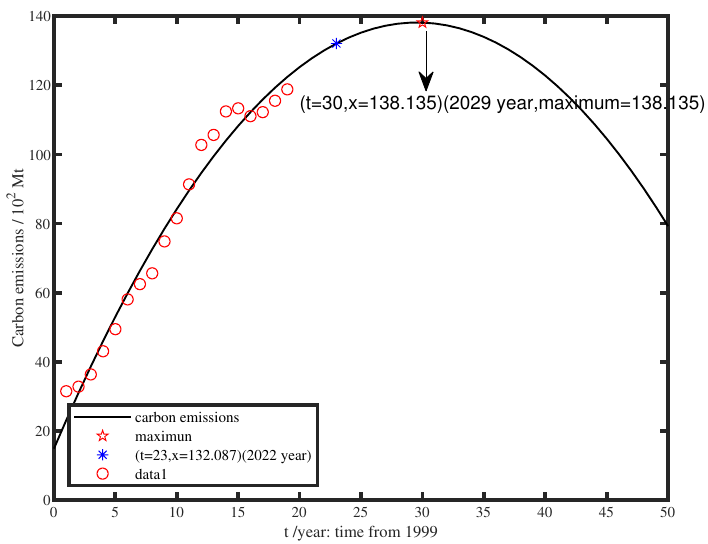
Figure 1. Carbon emission data from 2000 to 2018 and fitting curve.